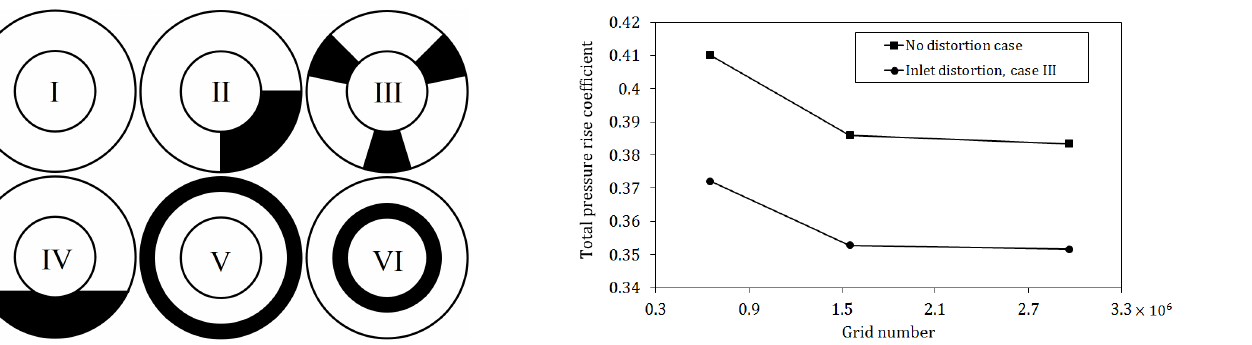
Figure 4. Grid independency results.